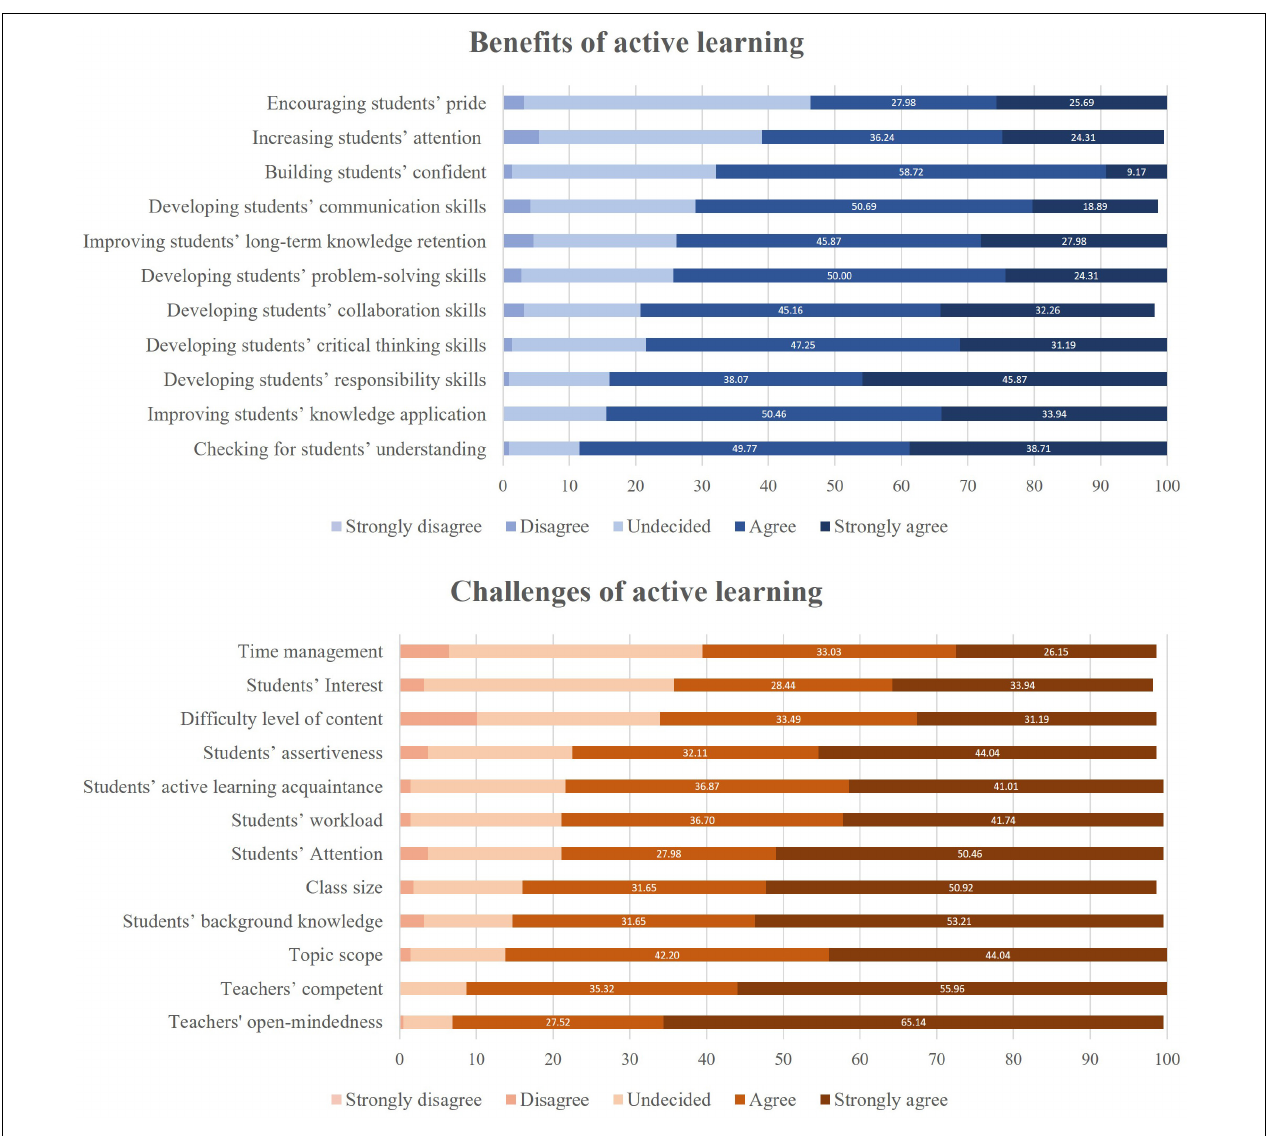
FIGURE 2 | Benefits and challenges of active learning from the quantitative